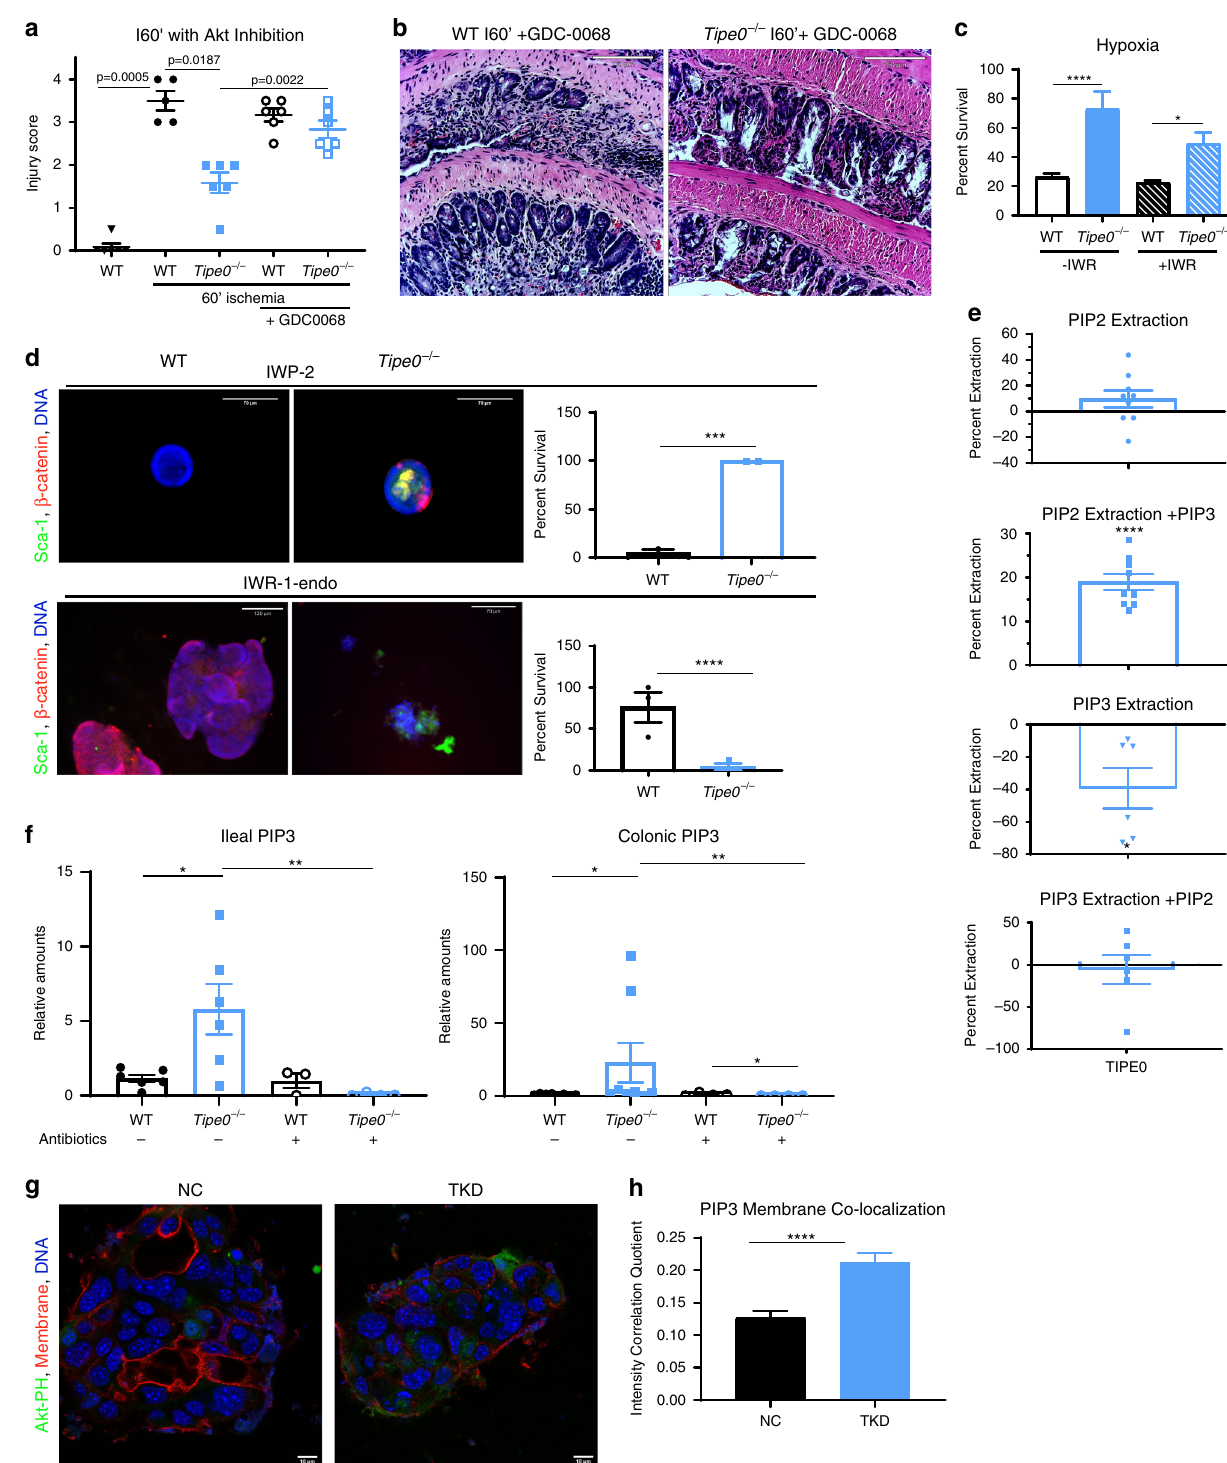
fi nal washes with 0.2% TBS-Tween and 1X TBS, membranes were analyzed with Pico or Femto ECL reagent (Thermo Fisher) using a LiCor Odyssey imaging system (Li-cor, Lincoln, NE). For the β -catenin Western blot in Fig. 8C, Jackson ImmunoResearch (West Grove) 800 nm anti-Rabbit was used as a secondary and imaged directly with the LiCor system. All cropped blot images in the fi nal fi gures are outlined in black and all compared bands were processed in Adobe Photoshop equally and at the same time using the Auto Tone function for image clarity. Raw images were used for densitometry analysis. Uncropped blots are provided in the source data fi le.